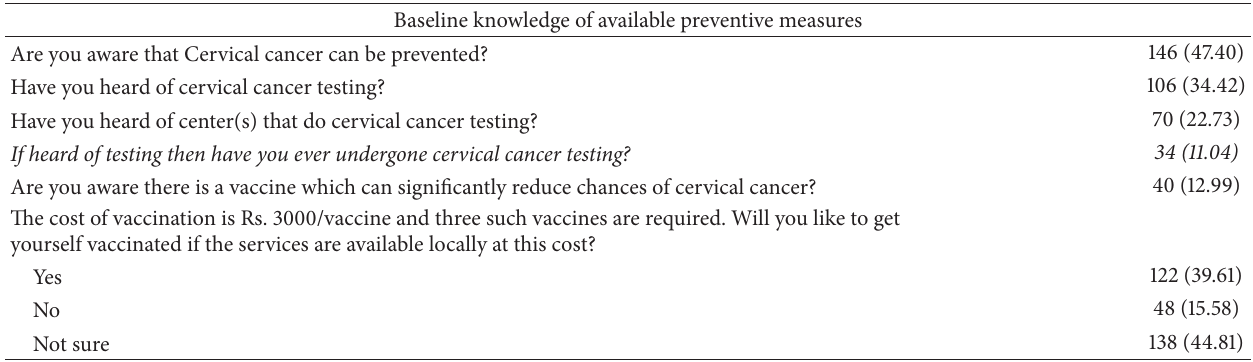
Table 4: Survey result